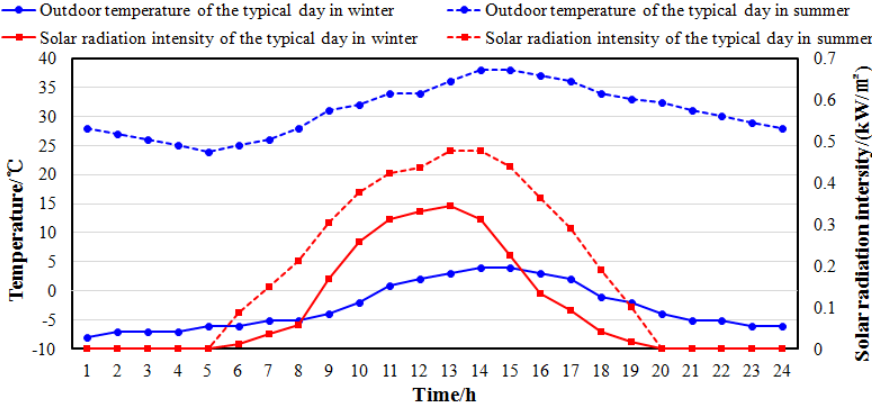
Figure 4. Forecasted curves of solar radiation intensity and outdoor temperature. Processes 2019 , 7 , x FOR PEER REVIEW